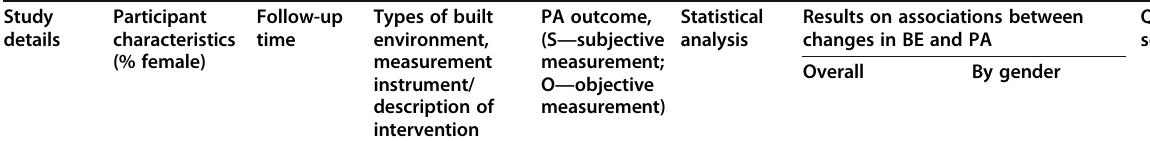
Table 1 Study characteristics